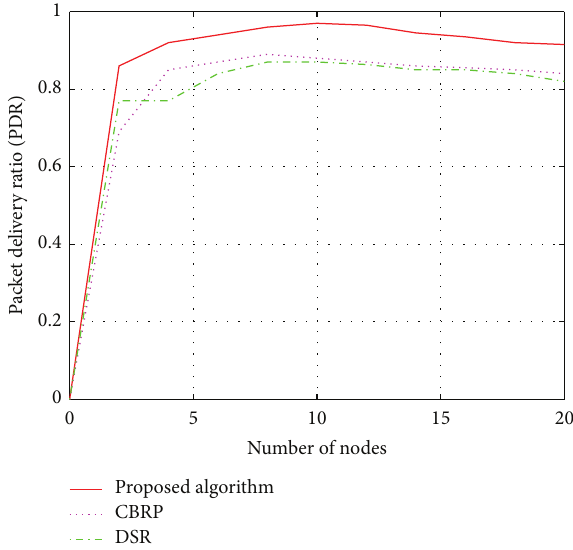
Figure 5: The effect of SH election process in swarm stability.